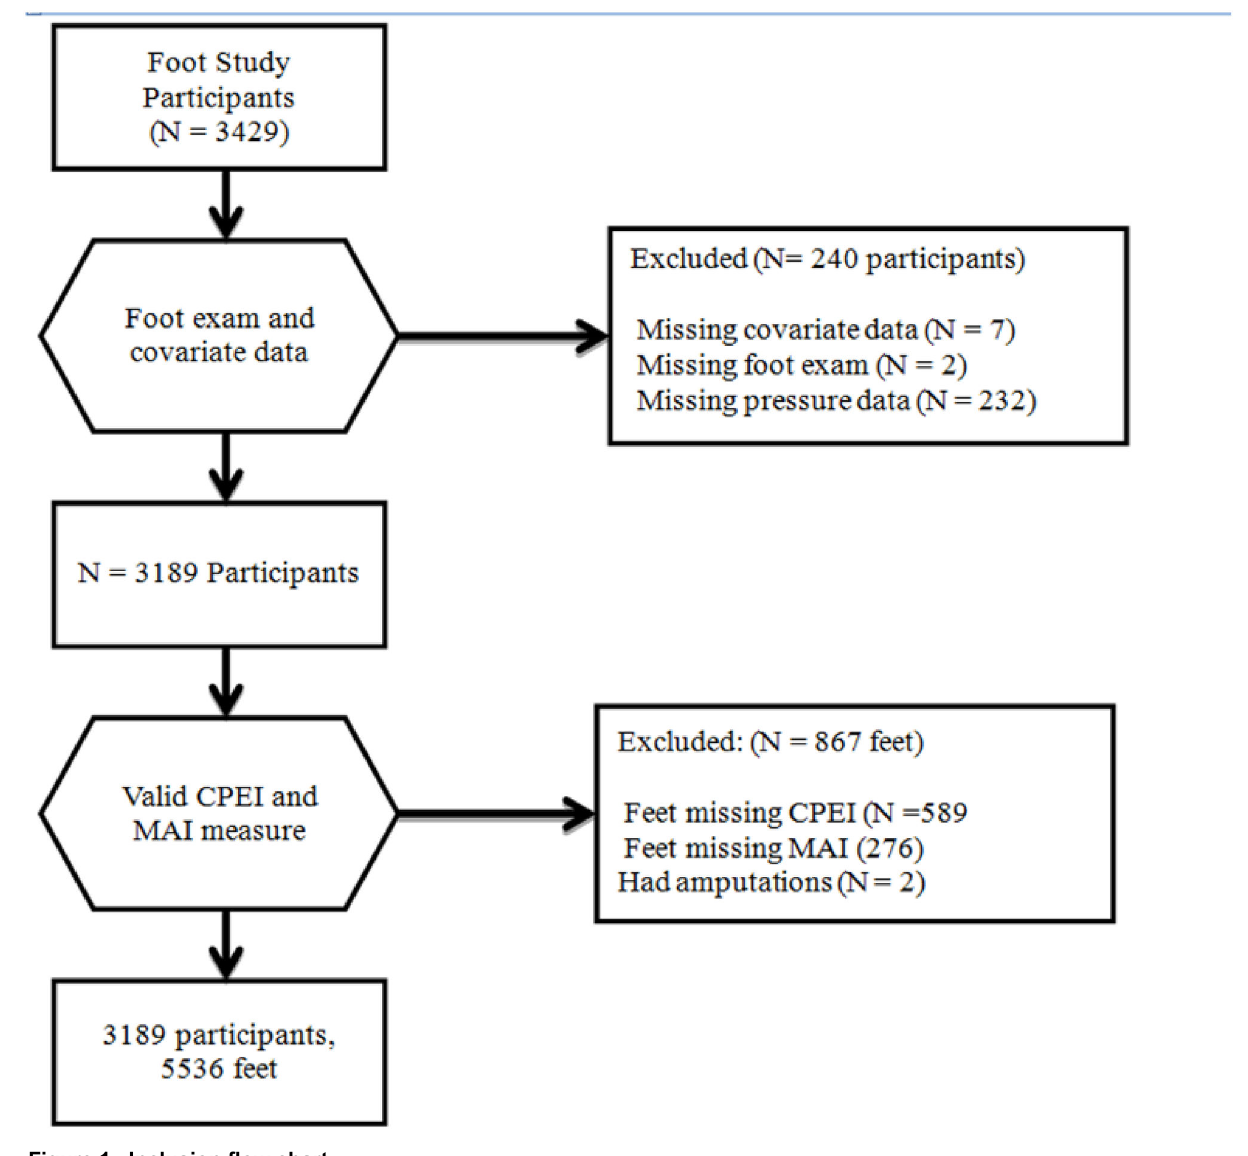
Figure 1. Inclusion flow